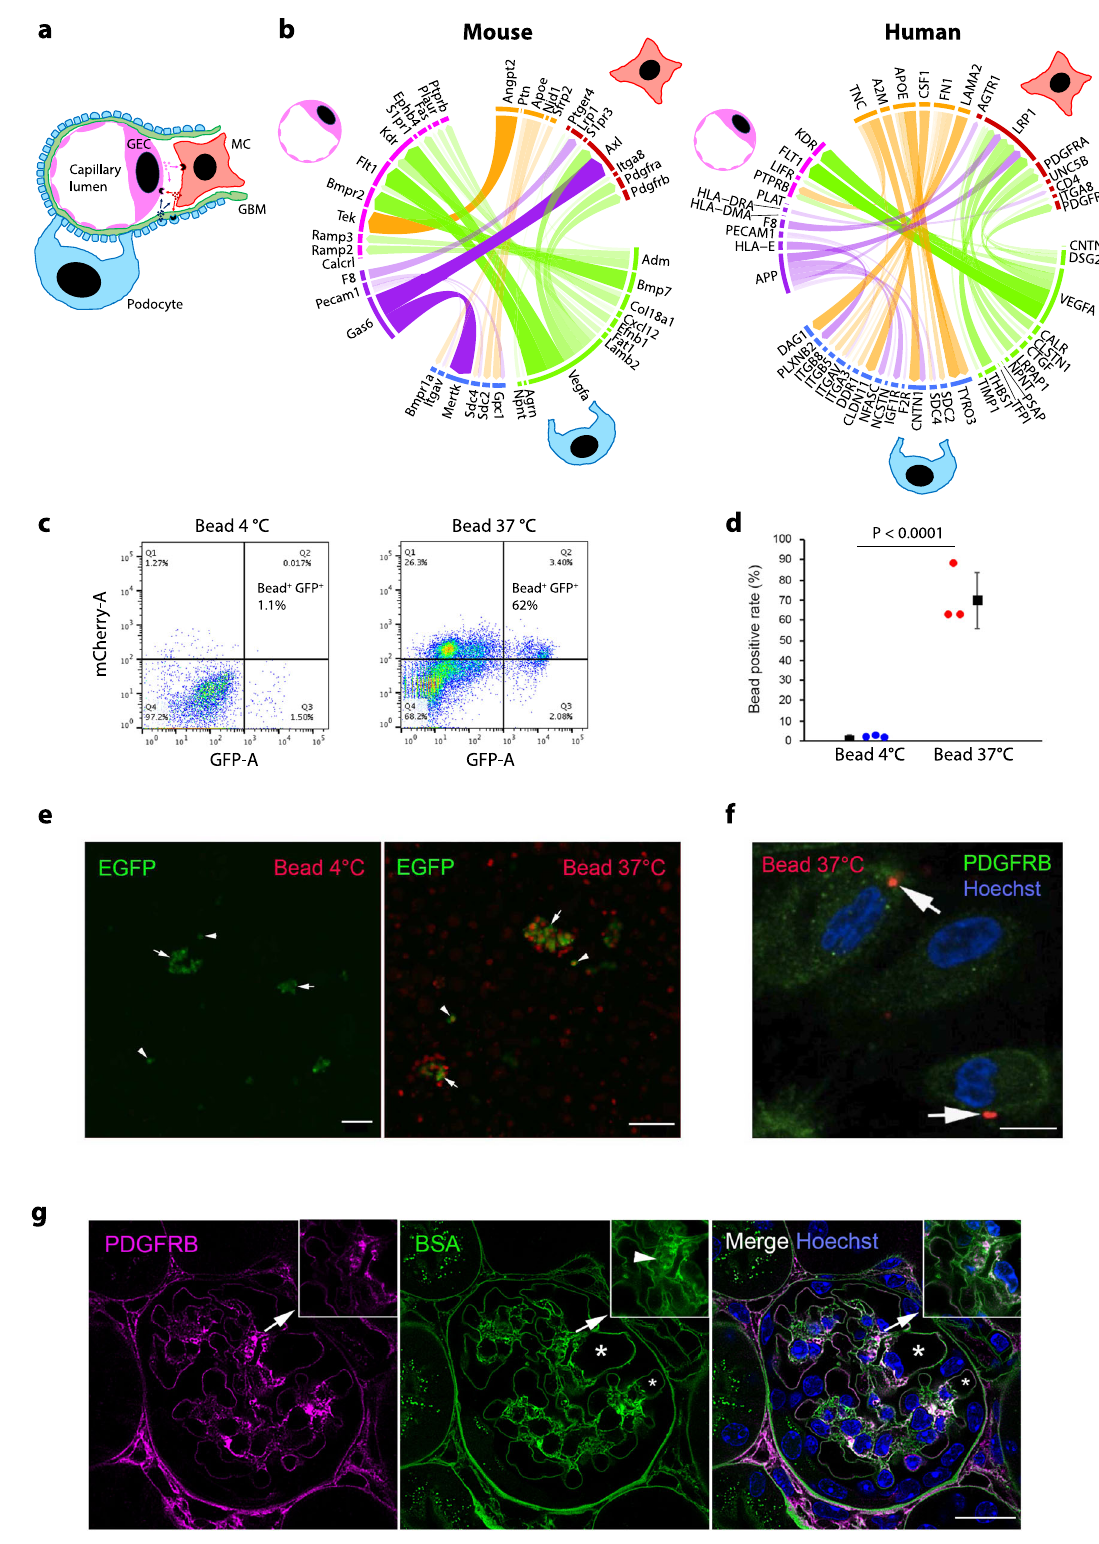
was used for comparative analysis between two species. A total of 170 GEC genes showed high expression in both species, of which fi ve genes ( Ehd3 , Kdr , Igfbp5 , Emcn and Tmem204 ) were speci- fi cally upregulated in GECs compared to other captured renal cell types (Fig. 6a, b and Supplementary Data 10). In contrast to podocytes and MCs, we detected only six human-speci fi c and